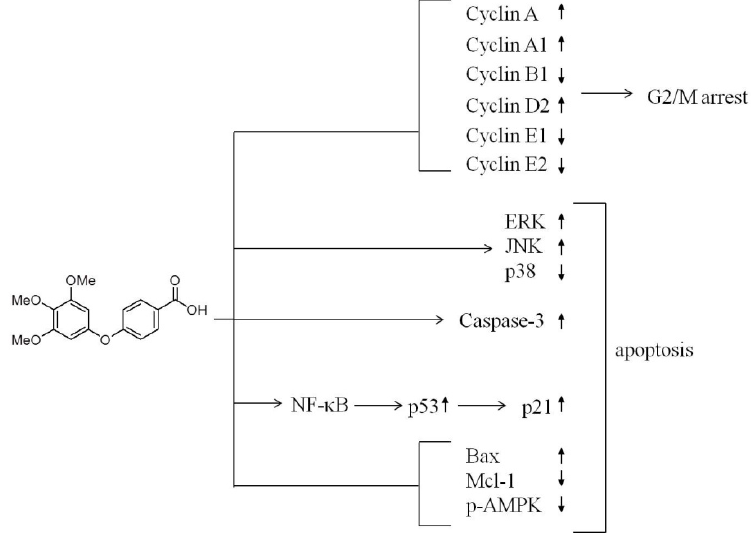
Figure 7. Diagram depicting the effect of TMPBA on cell cycle regulatory proteins, MAP kinases, and p53. The interplay between these signaling networks at different cellular levels results in the ability of TMPBA to induce apoptosis in MCF-7 breast cancer